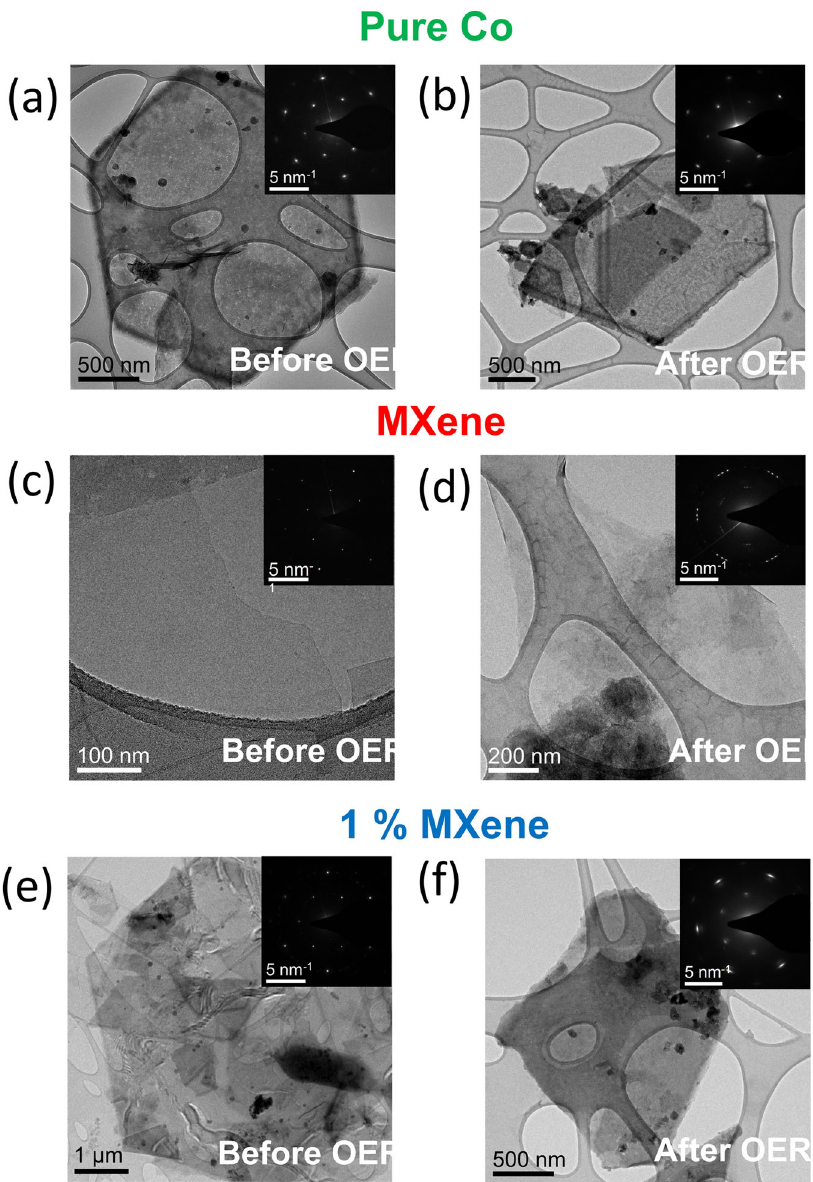
Fig. 4 TEM investigation before and after OER. TEM images and corresponding SAED patterns for the pure Co ( a ) before OER, ( b ) after OER. TEM images and corresponding SAED patterns for the pure MXene ( c ) before OER, ( d ) after OER. TEM images and corresponding SAED patterns for the 1% MXene ( e ) before OER, ( f ) after